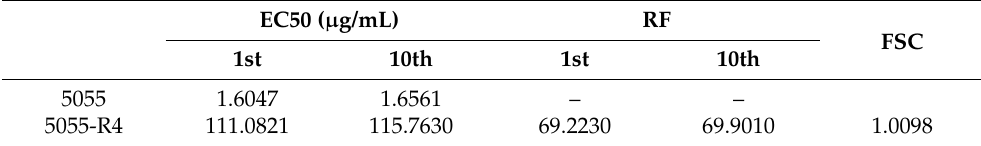
Table 1. Resistance level and stability of B. cinerea mutants to SYAUP-CN-26.